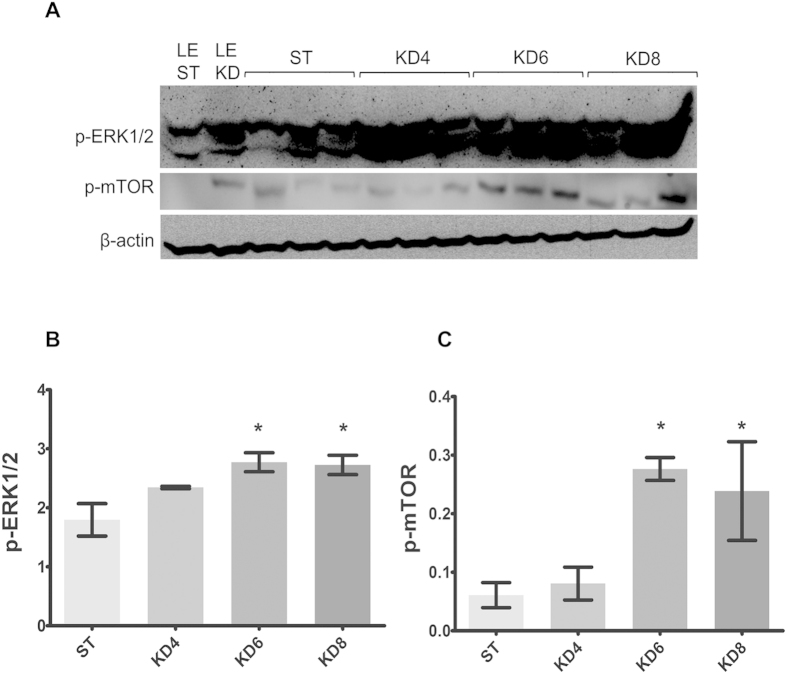
Immunoblot analysis of kidney lysates.(A) Blot membranes were incubated with the antibodies against p-ERK1/2 Thr 202/204 and p-mTOR Ser 2448. The mean integrated optical density is related to actin for p-ERK1/2 (B) and p-mTOR (C) activity. Results are given as a mean ± S.E.M. KD4, KD6, KD8 – groups of Eker rats (Tsc2+/−) treated with HFKD for four, six or eight mo., respectively; ST – Eker rats fed with a standard diet; LE ST – wild-type Long Evans rats treated with a standard diet; LE KD – wild-type Long Evans rats treated with a ketogenic diet similarly to the KD6 group. *P < 0.05 as compared to ST for ANOVA with a Fisher post hoc test.